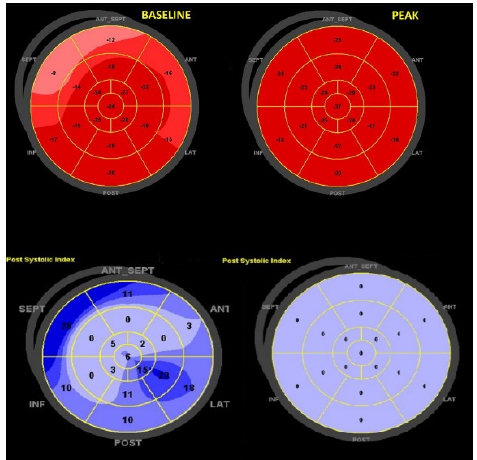
Figure 3. Comparison between baseline and peak GLS values. At baseline, there is a reduced lon- gitudinal strain in the basal walls along with a moderate amount of post-systolic strain, typical of hypertension. At the peak, there is an increase in all segments (with now a PSI of 0), findings consistent with absence of ischemia and good response with stress. GLS = global longitudinal strain; PSI = post-systolic index.